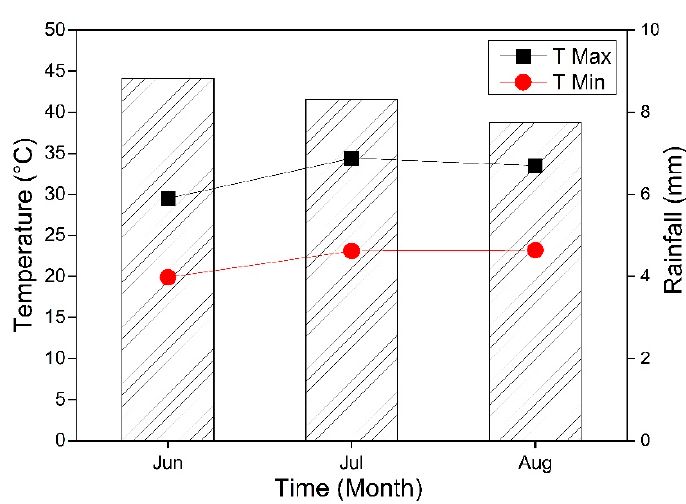
Figure 1. Location of study site.